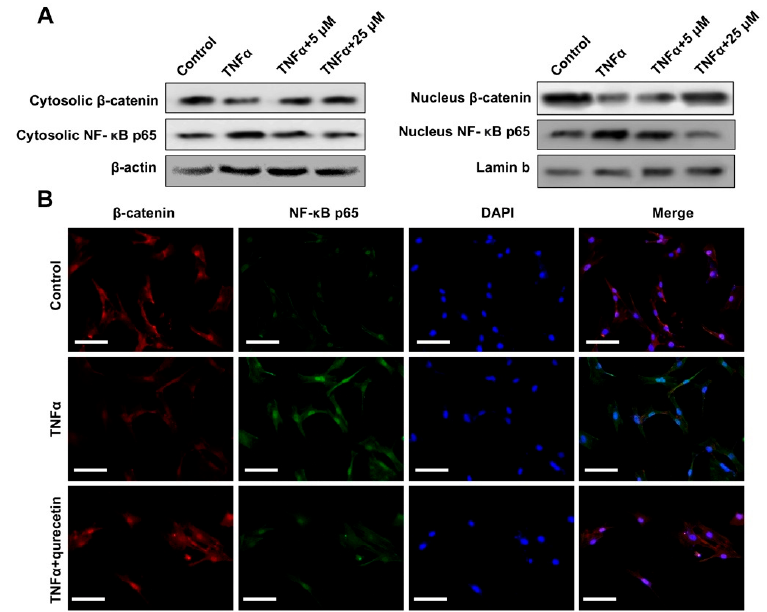
Figure 3. Quercetin reversed TNF α increased NF- κ B and decreased Wnt/ β -catenin signaling activi- ties. ( A ) Western blot analysis of NF- κ B p65 and β -catenin nucleus translocation of the BMSCs upon TNF α pre-treatment and quercetin administration. ( B ) Immunofluorescence (IF) staining analysis of the β -catenin and NF- κ B p65 nucleus translocation of the BMSCs upon TNF α pre-treatment and quercetin administration. DAPI was included as an internal control. Scale bar: 100 µM. 2.3. Quercetin Could Reverse the Expression of lncRNA Malat1 Downregulated by TNF α Treatment Real-time PCR analysis result indicated that the mRNA expression levels of H19, Ho- tair and Dancr were increased upon TNF α administration, and quercetin had a limited effect on them (Figure 4A–C). The mRNA expression level of lncRNA MEG3 was not ob- viously altered in response to TNF α and quercetin (Figure 4D). However, the relative Ma- lat1 mRNA expression level was inhibited by TNF α while restored by a range of concen- trations of quercetin (Figure 4E). Therefore, Malat1 may play an intermediary role in quer- cetin-enhanced BMSCs osteogenesis.